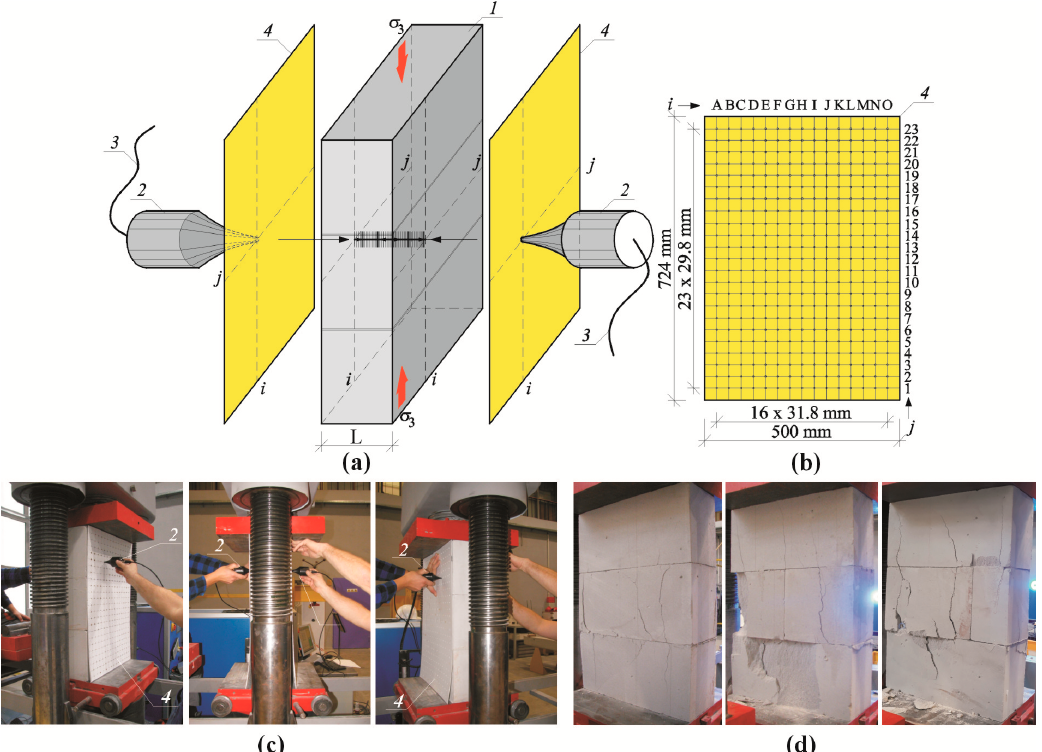
Figure 8. Testing methodology for models made of AAC used in stage II: ( a ) measurement of velocity of ultrasonic wave propagation at different stress values σ 3 , ( b ) template geometry used for symmetric arrangement of ultrasonic transducers, ( c ) models during tests, ( d ) failure of selected models 1 —masonry units, 2 —ultrasonic transducers, 3 —cables connecting transducers with recording equipment, 4 —templates for symmetric location of ultrasonic transducers. Table 3. Test results for all models.